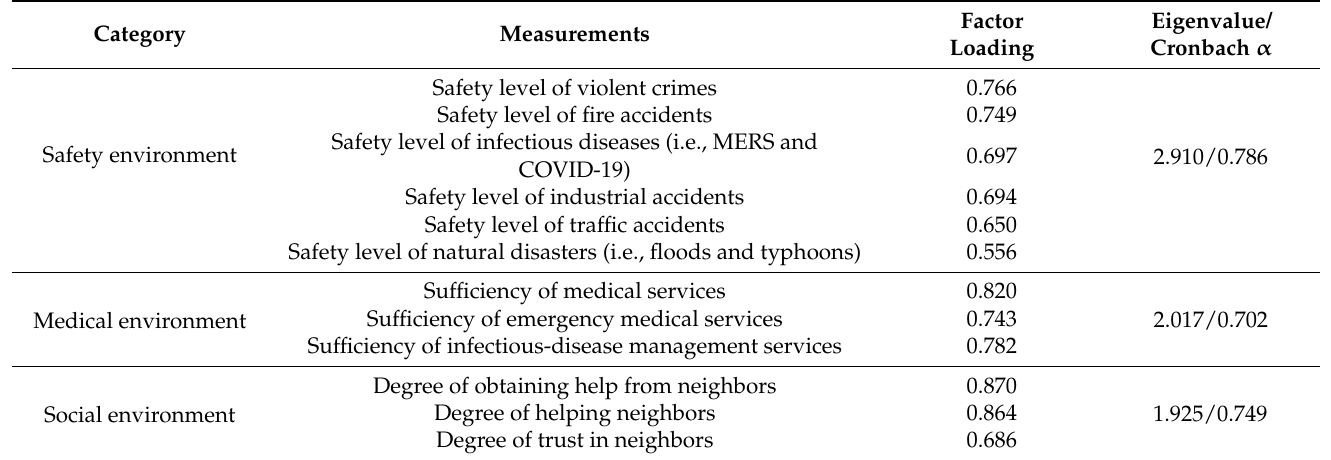
Table 2. Exploratory factor analysis and reliability analysis: Perceptions of community